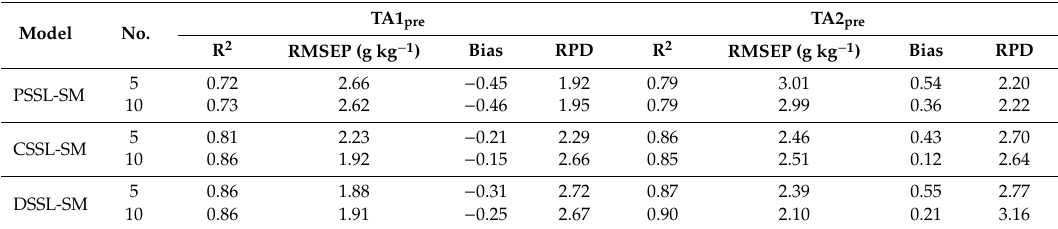
Table 6. Statistical results of prediction performance of spiked models (SM).